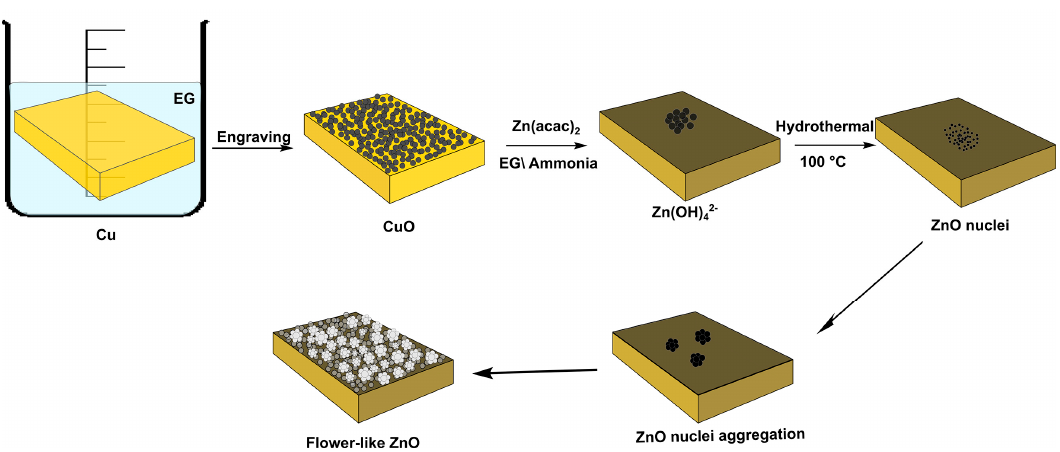
Scheme 1. Schematic illustration of the flower-like CuO-ZnO synthesis